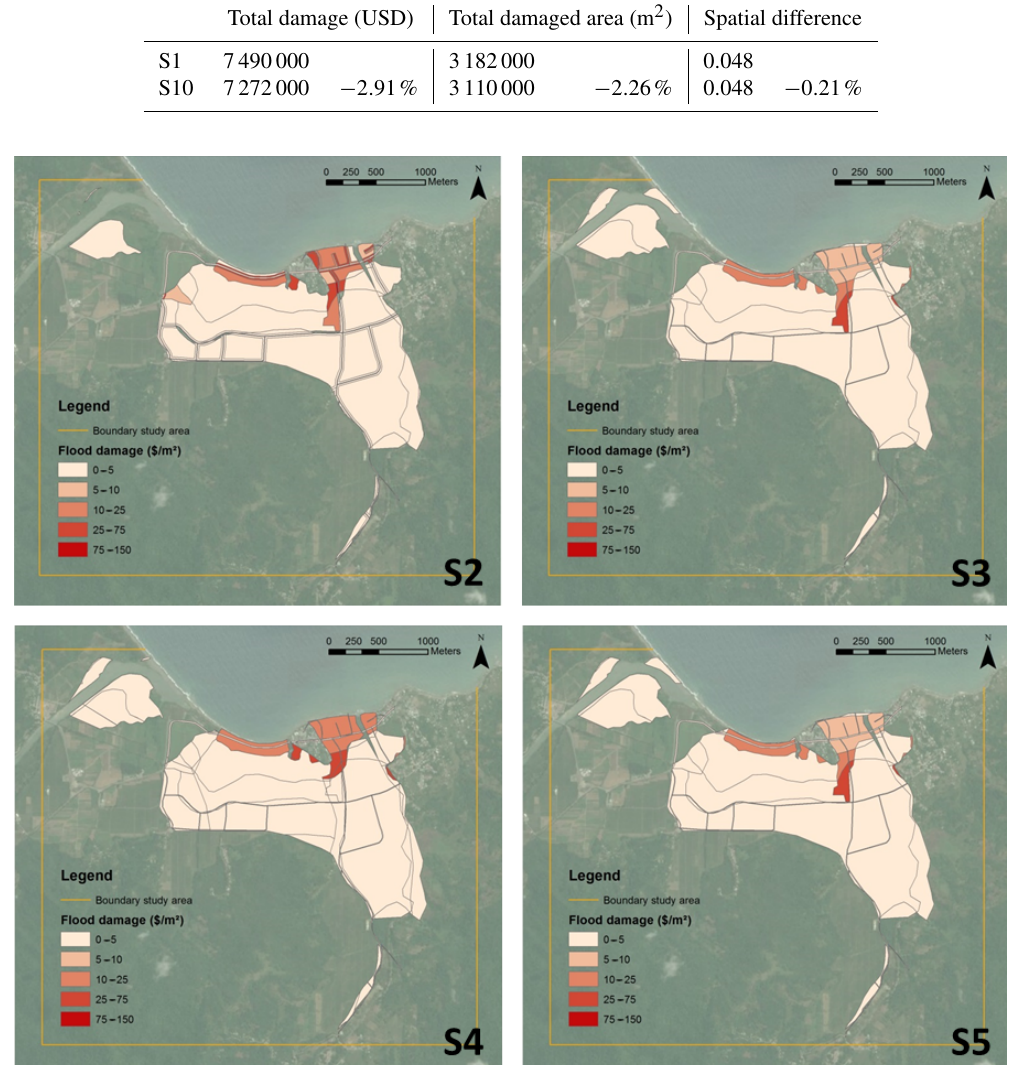
Figure 5. Damage maps for Annotto Bay for S2, S3, S4 and S5. Top left: (S2) building materials and number of floors unknown; top right: (S3) building locations, materials and number of floors unknown; bottom left: (S4) building density is calculated based on population density; bottom right: (S5) building density is calculated based on number of people in study